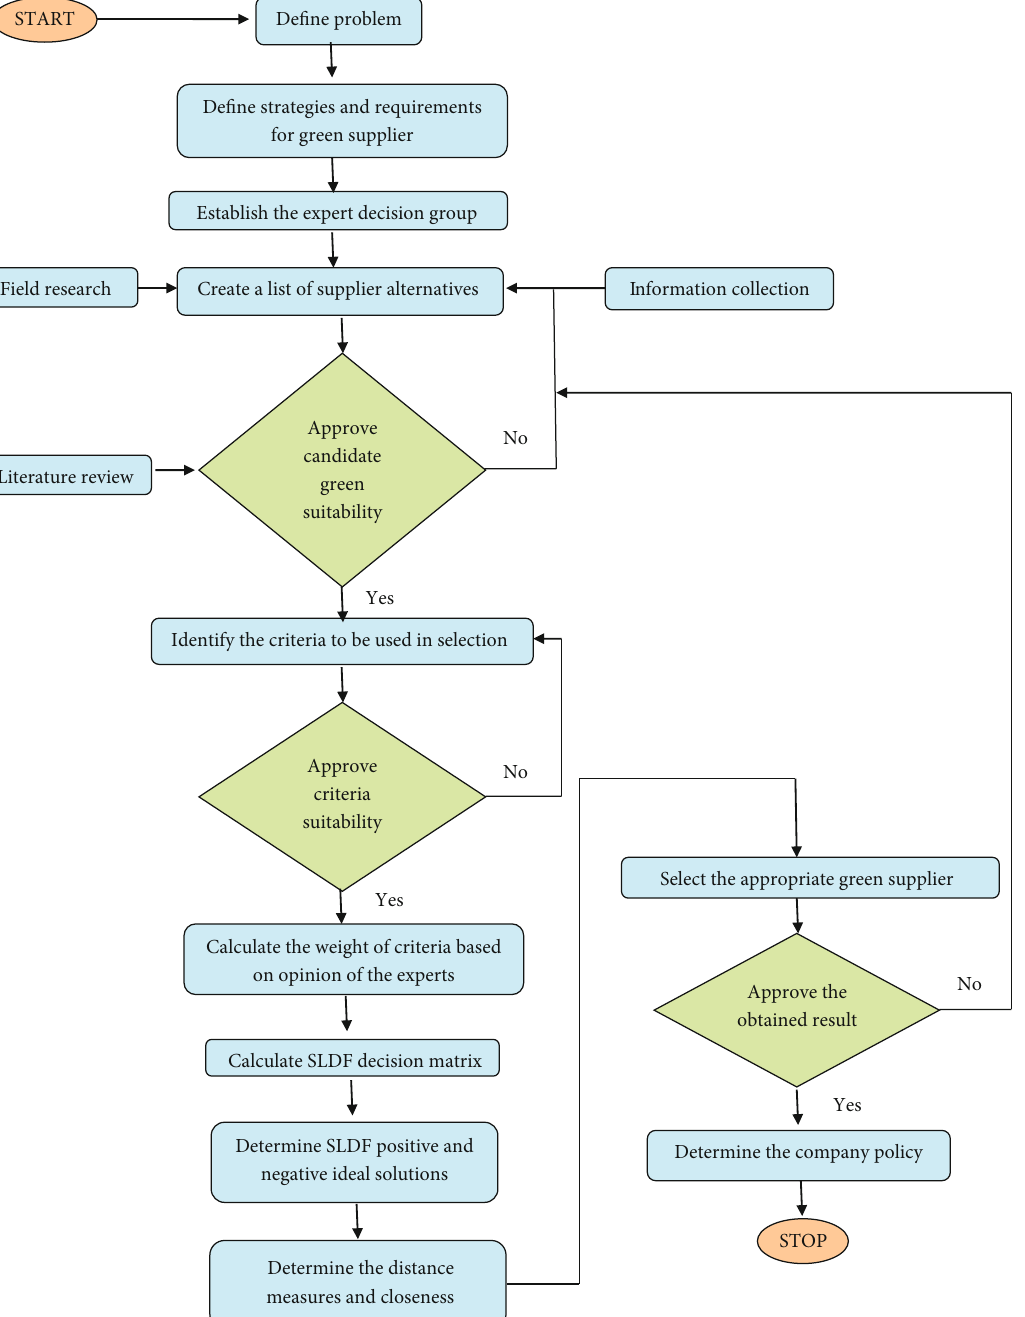
Figure 1: Flow diagram of the proposed